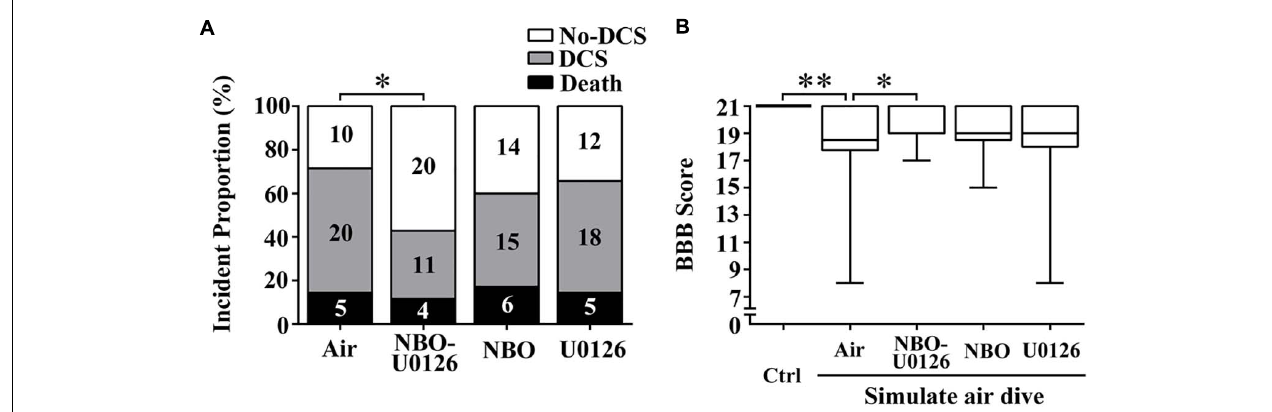
FIGURE 3 | Effects of NBO-U0126 on DCS incidence and motor function in rats. Rats were treated with NBO and/or U0126, 12 h prior to simulated air dives. The BBB scale was used to evaluate rat hindlimb motor function. (A) Incidence of DCS ( n = 35, the numeric values in the bars are numbers of rats); (B) motor function